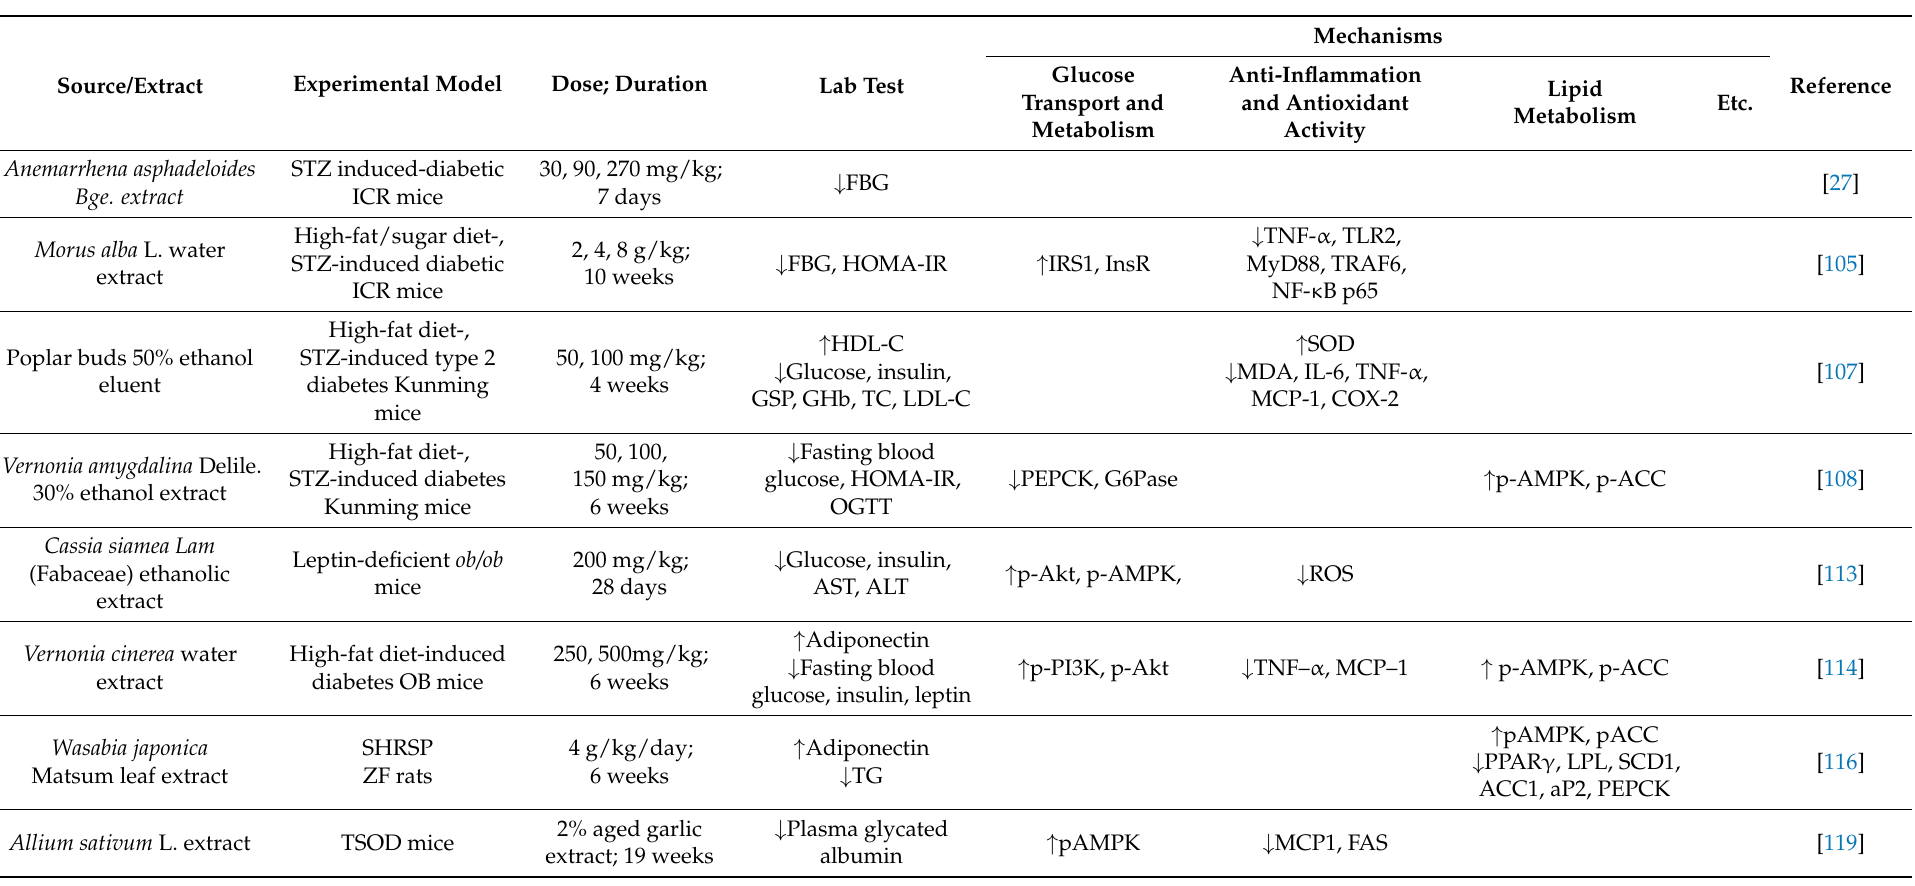
Table 6. Other preclinical